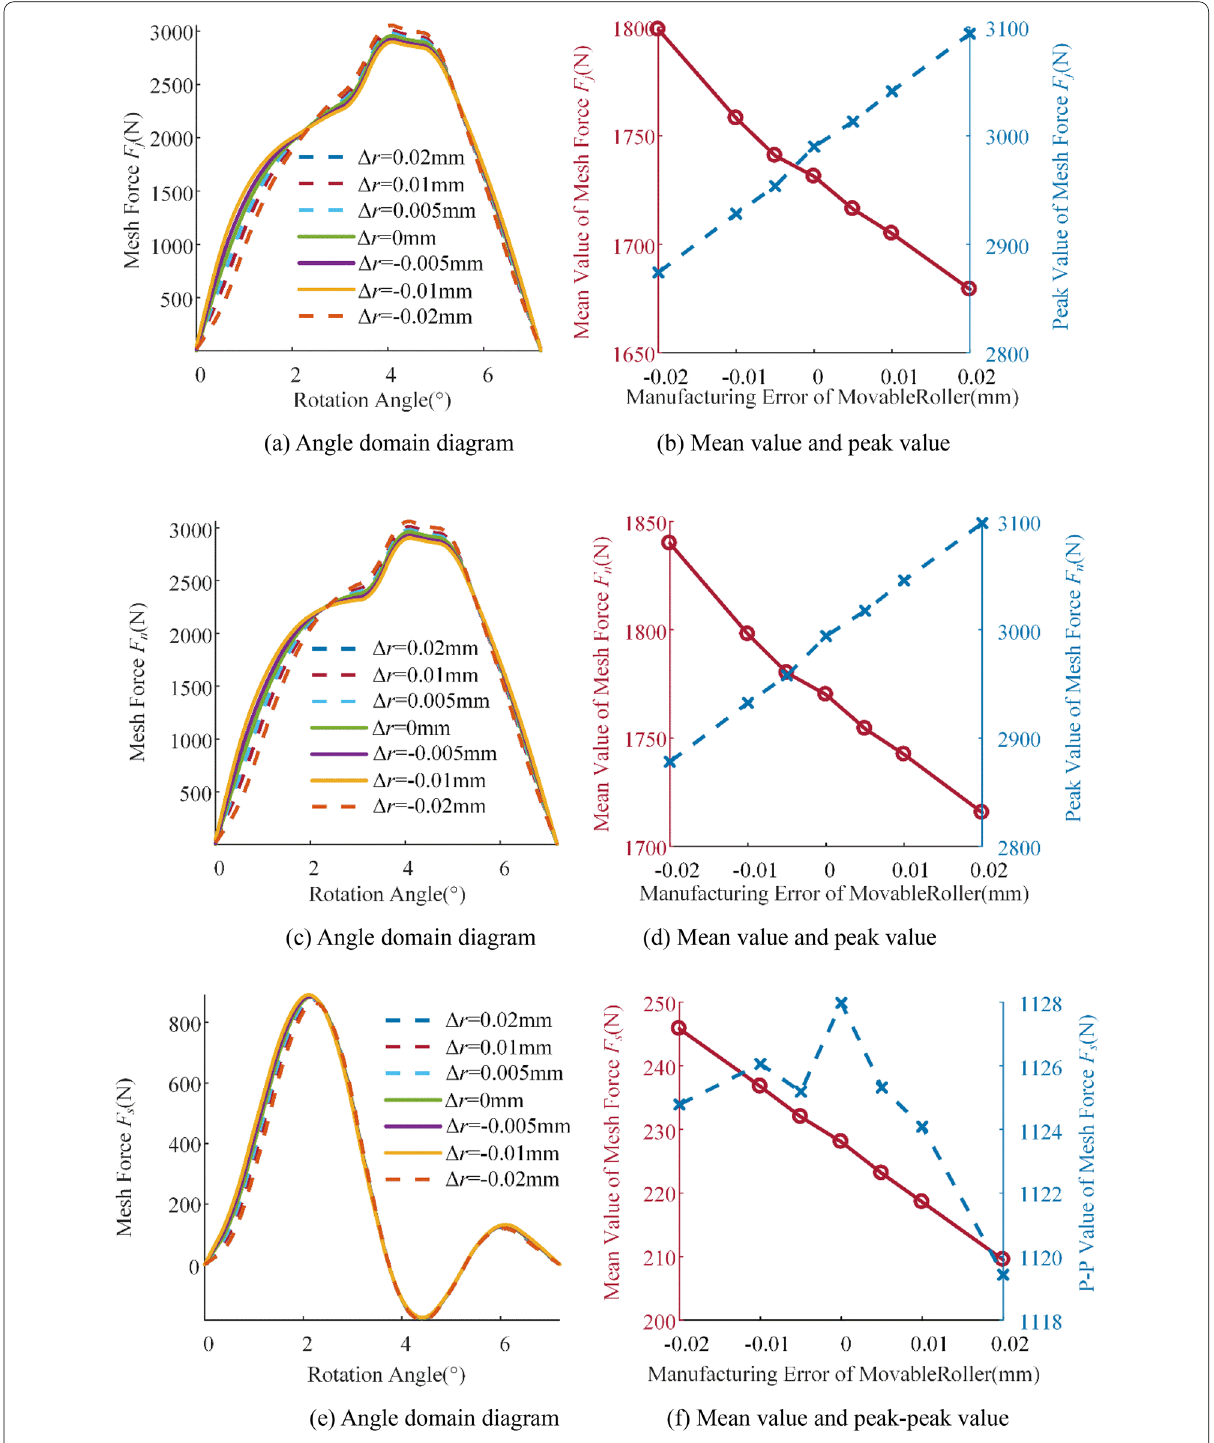
Figure 16 Impacts of manufacturing error of movable roller on mesh